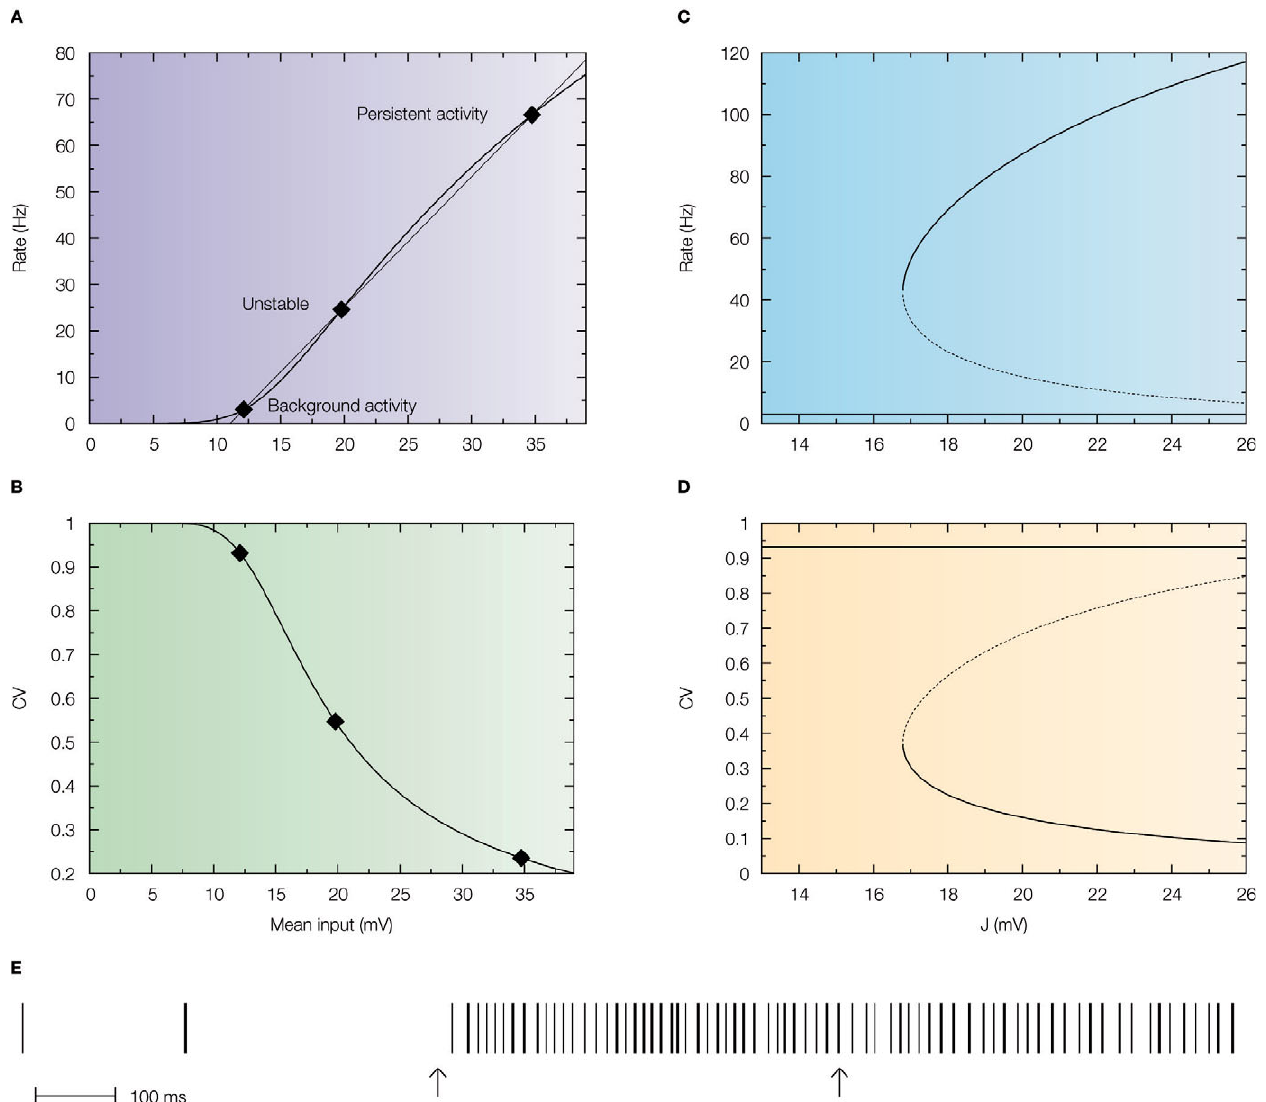
Figure 4 | Standard attractor network models produce highly regular persistent activity. Mean fi ring rate and CV of a population of excitatory leaky integrate- and-fi re neurons with low reset (10 mV below threshold) connected by linear excitatory synapses (see Barbieri and Brunel, 2007 for more details). (A) f-I curve (fi ring rate of a single LIF neuron as a function of mean input). The intersections between the f-I curve (thick line) of the LIF neuron and the straight line (thin line) correspond to solutions of the mean-fi eld equation, shown by diamonds, for a particular value of the synaptic effi cacy. The three solutions correspond to the background activity state (stable), the limit of the basin of attraction (unstable) and the persistent activity state (stable). (B) CV-I curve (CV of a single LIF neuron as a function of mean input). Diamonds: Values of the CV for the three states shown in (A) . (C) Bifurcation diagram showing fi ring rate of the excitatory network as a function of synaptic strength J . The background activity corresponds to the horizontal curve (lowest branch), the dotted curve (intermediate branch) is the boundary of the basin of attrac- tion and the black curve (highest branch) represents the evolution of the persistent activity. (D) Bifurcation diagram showing how the CV depends on J : the persistent activity (black curve, lowest branch) has a CV which is well below the CV of the background activity (highest branch, red curve) for all values of J . (E) Spike train of one of the cells of the network (simulation of a network of 1000 neurons). Arrows indicate beginning and end of presentation of the stimulus, so the second arrow indicates the beginning of the delay period. Note the high regularity of the spike train in the delay